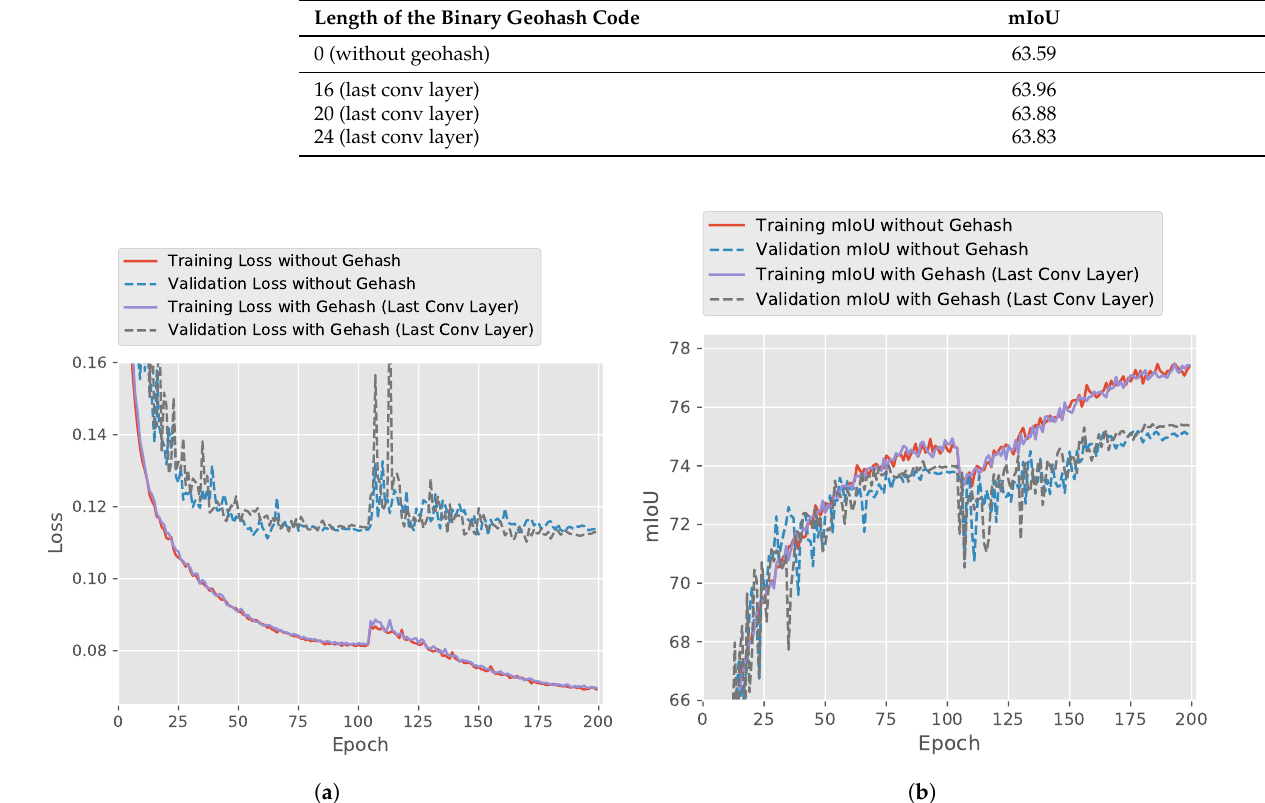
Figure 8. Learning curves for the Inria dataset: ( a ) the curve of the loss; ( b ) the curve of